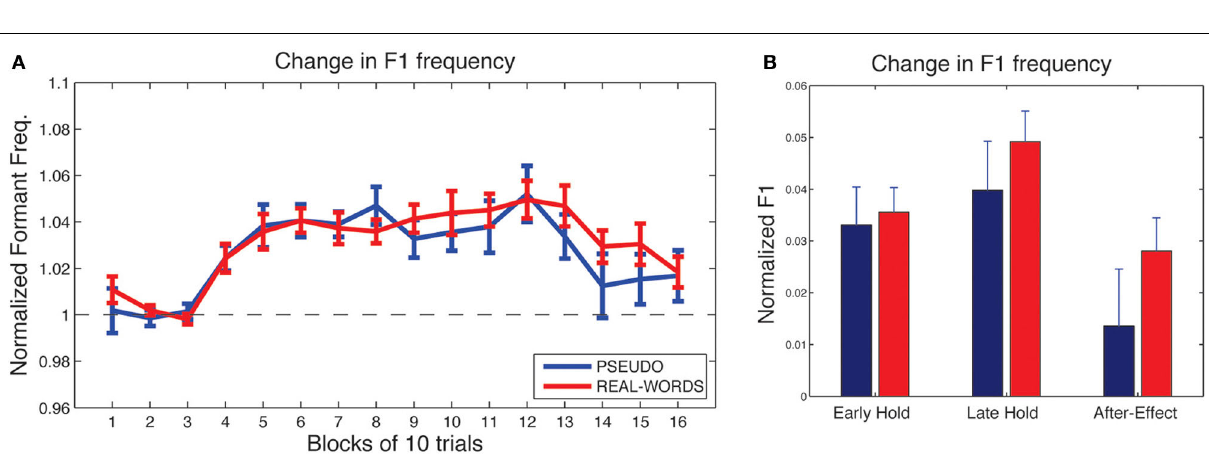
FIGURE 5 | Results of speech adaptation task for the two non-lexical-change groups (NLC-1 and NLC-2). (A) Mean normalized F1 frequency is shown throughout the task, averaged over successive blocks of